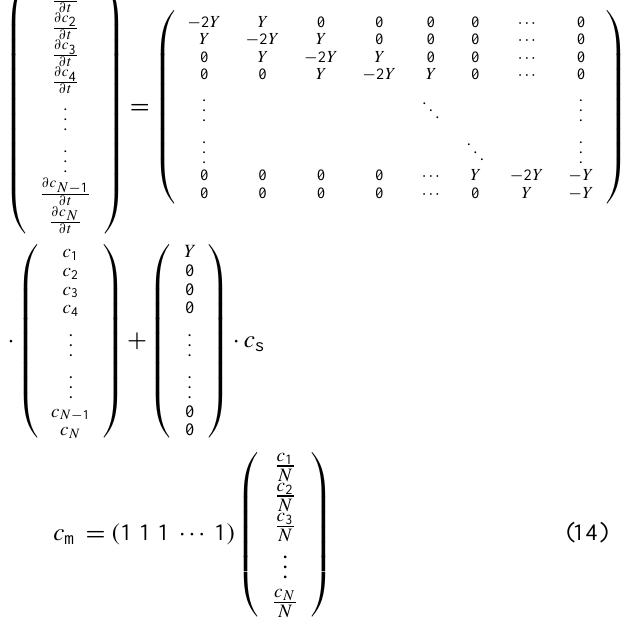
Figure 5. Result of a step response experiment with rising-edge (up- per figures) and falling-edge (lower figures) humidity in comparison to model results. The model was run with 40 layers and a diffusion coefficient D = 0.38µm 2 s − 1 in all